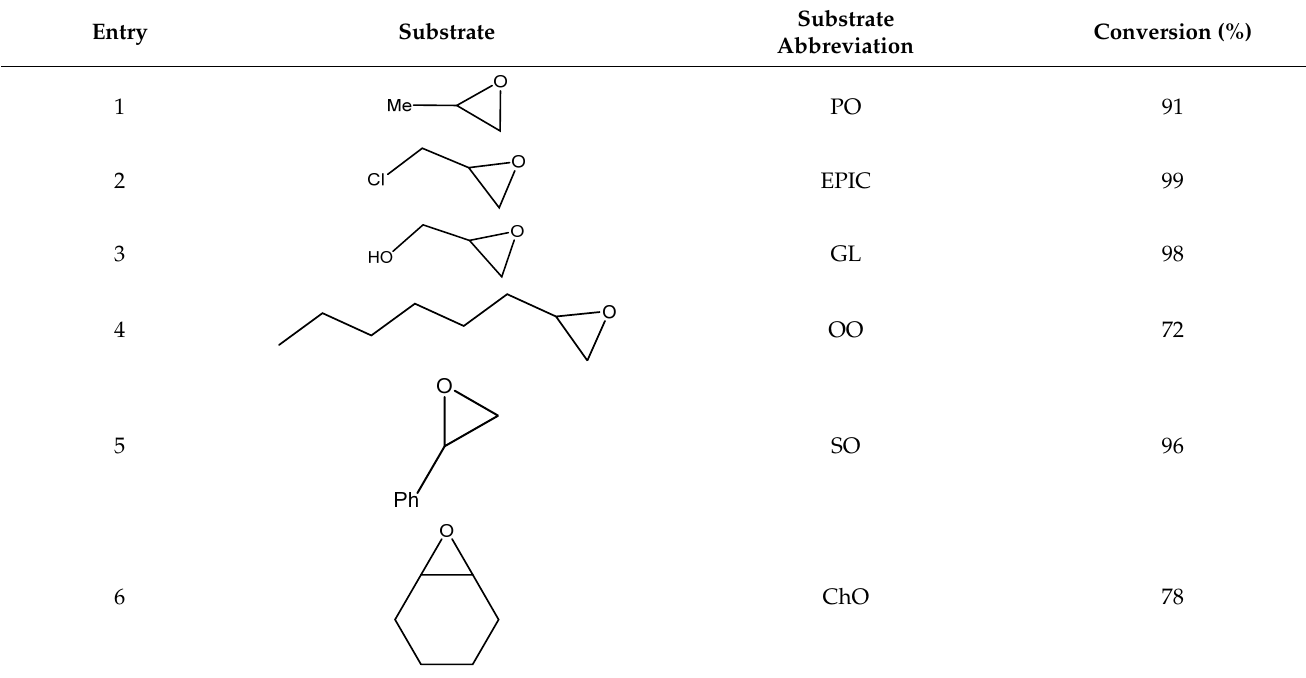
Table 12. PC synthesis catalyzed by DABCO-based Lewis basic ionic liquids [29]. As was published by Yang et al., in the case of butylated DABCO (BuDABCO), the corresponding bromides, chlorides and hydroxides were recognized as the most effective cycloaddition catalysts [29] (Table 12, Entries 1–4). In contrast, non-nucleophilic